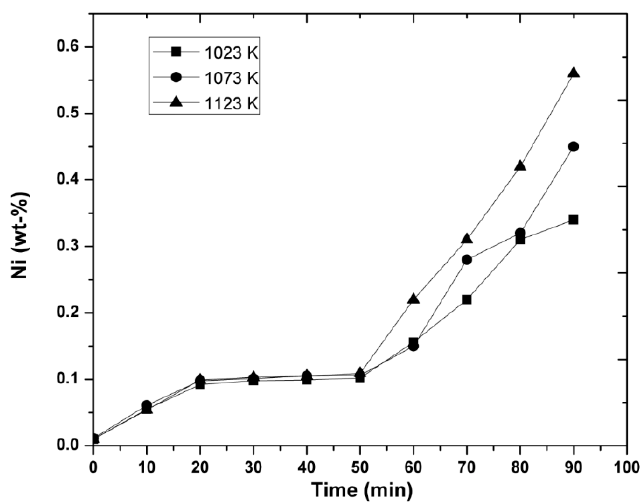
Figure 2. Increase in nickel concentration as a function of injection time at the indicated temperatures, for 0 wt-% Mg, and a constant agitation speed of 300 rpm.